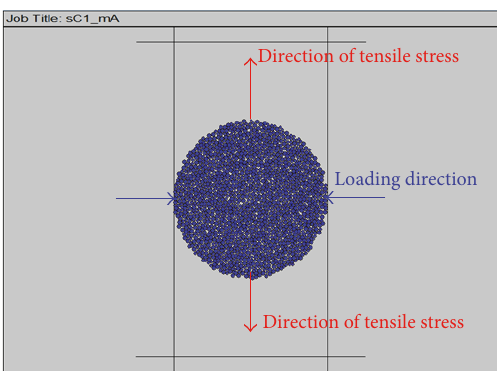
Figure 10: Schematic diagram of the loading direction.